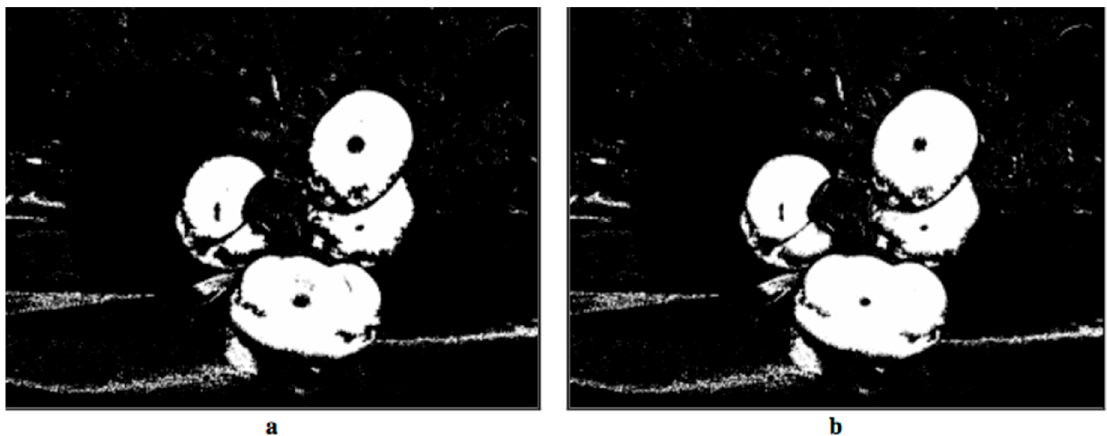
Figure 12. ( a ) Edge subtraction; ( b ) addition (OR) of Figure 10b and Figure 11b.